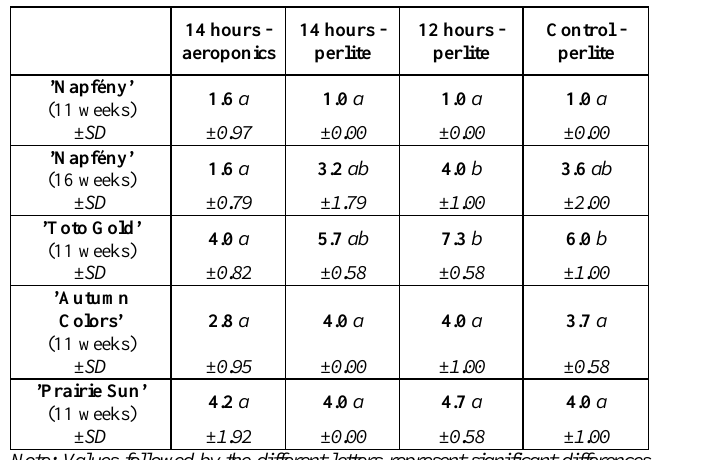
Table 3. Number of shoots of 11 and 16 weeks Rudbeckia hirta L. plantlets depending on photoperiodic lighting treatments and media (University of Debrecen, Biological Research and Plant Experiment Greenhouse - Biodrome, Debrecen, Hungary, 2021).